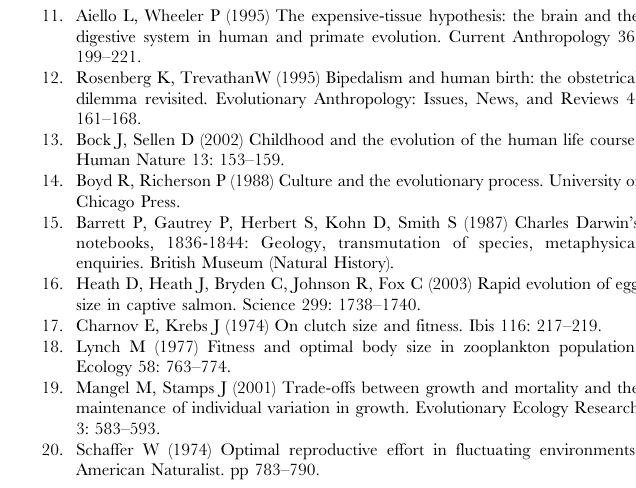
Figure S1 An example fitness curve for c = 4, E =0, and w from 2 5 to 5. It is very similar to the normal distribution curve but is easier to compute. (TIFF) Figure S2 The environment used in the analytical model. The environment increases in discrete steps of 1 each timestep for c timesteps, then drops to 0 in a single time step. (TIFF) Figure S3 Agent behavior in this environment over the first cycle. Dashed lines and diamonds indicate the phenotype of the agent, solid lines and circles the environment. The particlular x (maximum rate of phenotypic change) used here is x =0.5, but changing x will only change the amplitude of the cycle, not its phase or frequency. (TIFF) Information S1.